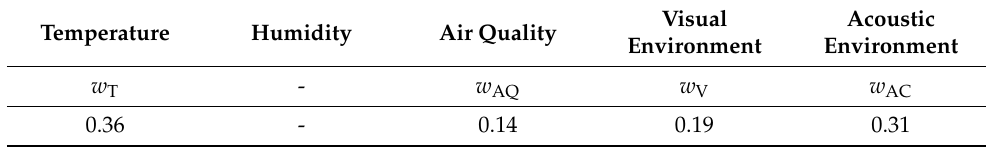
Table 12. Weightings of different indoor environment